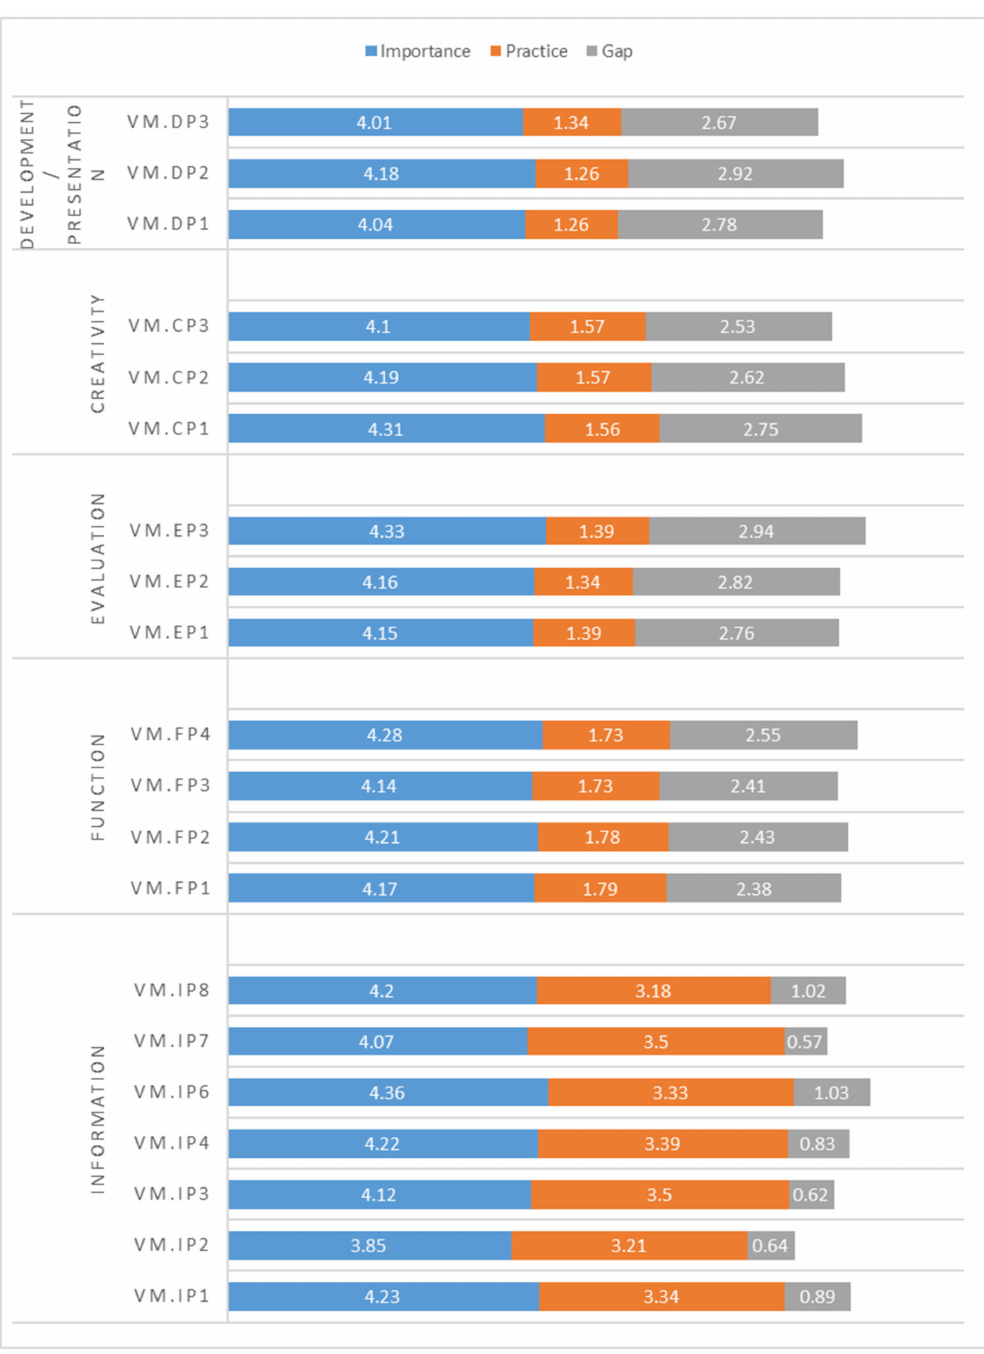
Figure 11. Gap analysis between the importance and practice levels of VM